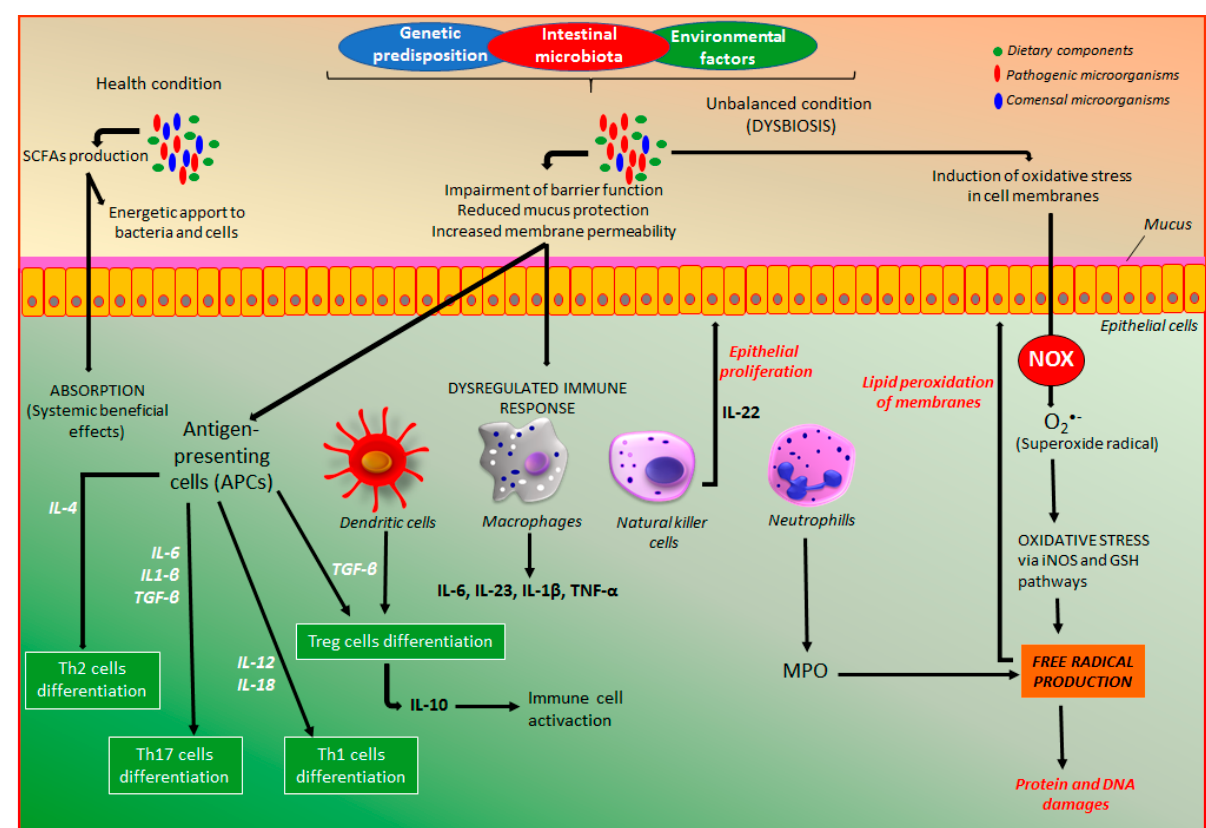
Figure 4. The main pathways of the intestinal inflammatory process or the action of coumarin derivatives. GSH, glutathione; IL, interleukin; iNOS, inducible nitric oxide synthase; MPO, myeloperoxidase; SCFAs, short-chain fatty acids; TGF, transforming growth factor; Th, T helper cells; Treg, T regulatory cells; TNF, tumor necrosis factor.